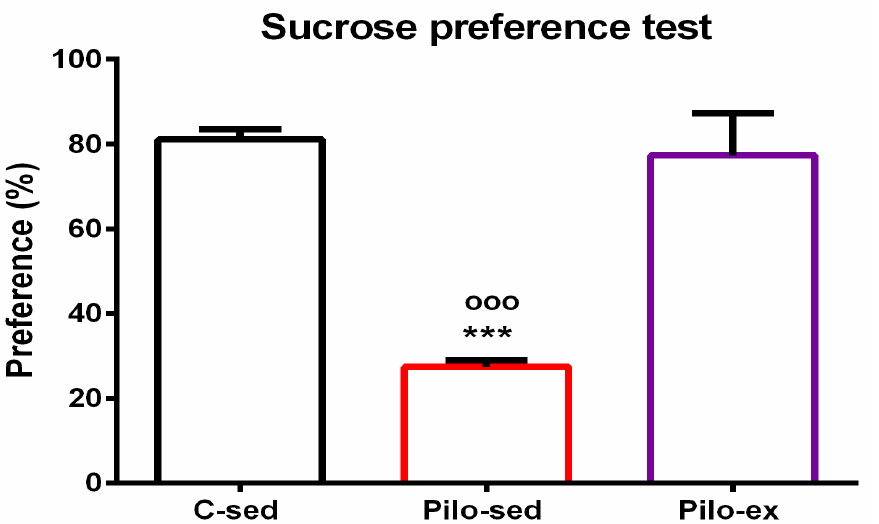
Figure 7. Effect of endurance training, applied before and after SE, on preference to sucrose solution in the sucrose preference test, *** p < 0.001 and ooo p < 0.001 in comparison with the C-sed group and Pilo-sed group, respectively.